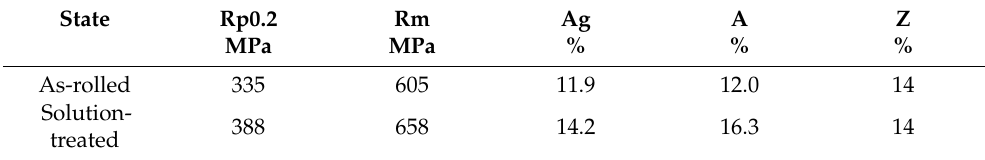
Table 5. Tensile test results at room temperature for different states of material.